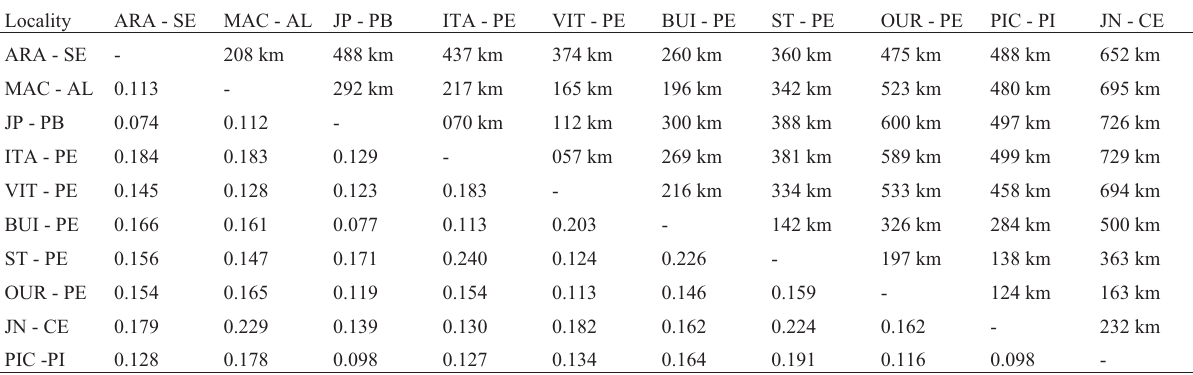
Table 6 - Mantel test based on pairwise F ST in 10 analyzed populations of R. brasiliensis .